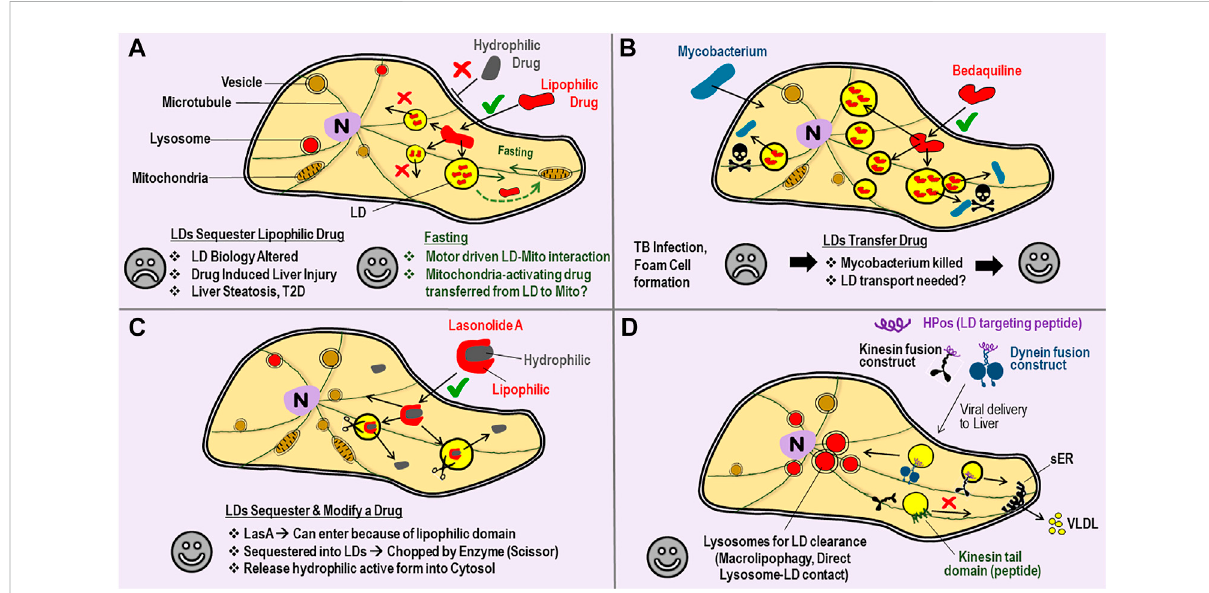
FIGURE 2 LipiddropletscanSequester,TransferorModifyDrugs – perhapsonecouldachievetargetedDrugDeliverybymanipulatingMotorsonLDs. (A) A cartoon view of a Cell. Bilayer lipid membranes are shown with double-lines (e.g., plasma membrane, vesicle membrane) to distinguish from the monolayer lipid membrane on Lipid droplets (LDs). Entry into cells through the plasma membrane is often easier for lipophilic drugs ( √ sign) as compared to hydrophilic drugs (× sign). Once inside, thelipophilic drug issequestered away into LDs from where it cannot escapeinto cytosol, and therefore becomes ineffective as a drug. Such drug sequestration can lead to some of the undesirable consequences listed (sad face). Fasting/ Starvation is known to increase LD-mitochondria interaction and consumption of LD-contents by mitochondrial β -oxidation. Perhaps hydrophobic drugs that can reverse mitochondrial degeneration can be packaged into LDs, and then delivered to mitochondria with a desirable outcome